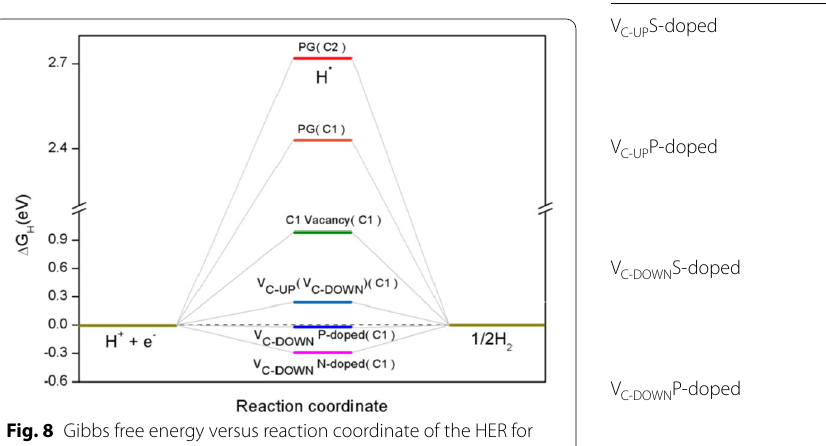
Table 3 Calculated Δ G